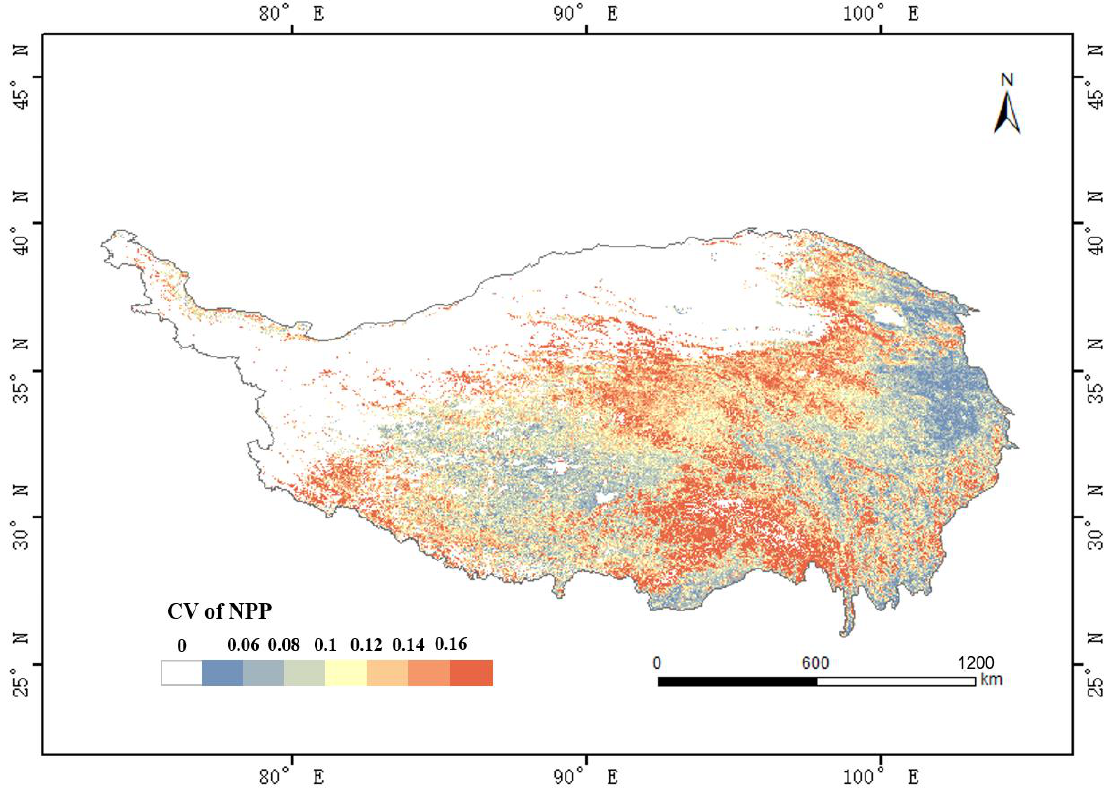
Figure 6. Spatial distribution of the coefficient of variation (CV) of NPP over the QTP from 2001 to 2017. Table 2. The proportion of different ranges of the NPP mean, trend and CV in QTP from 2001 to 2017.